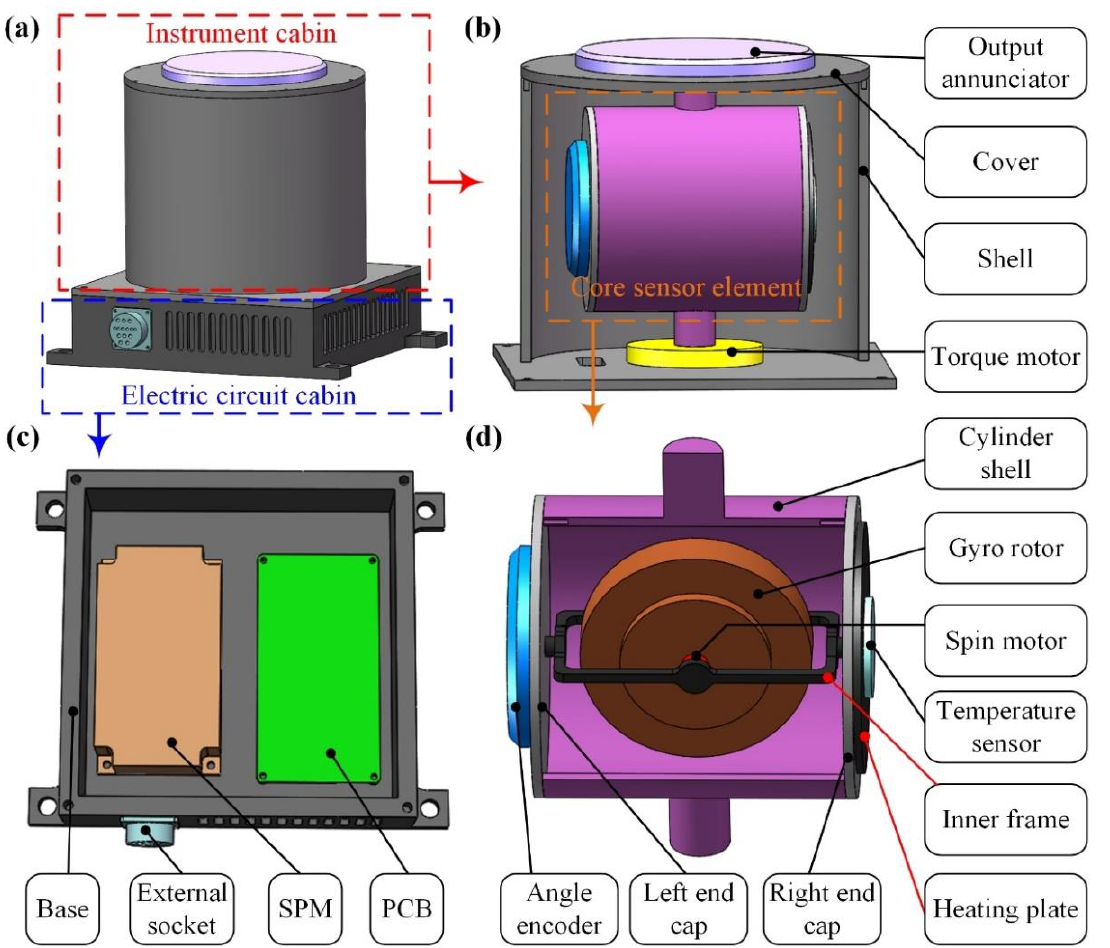
Figure 1. Structure of PIGA: ( a ) appearance of PIGA; ( b ) structure of the instrument cabin; ( c ) structure of the electric circuit cabin; ( d ) structure of the core sensor element.